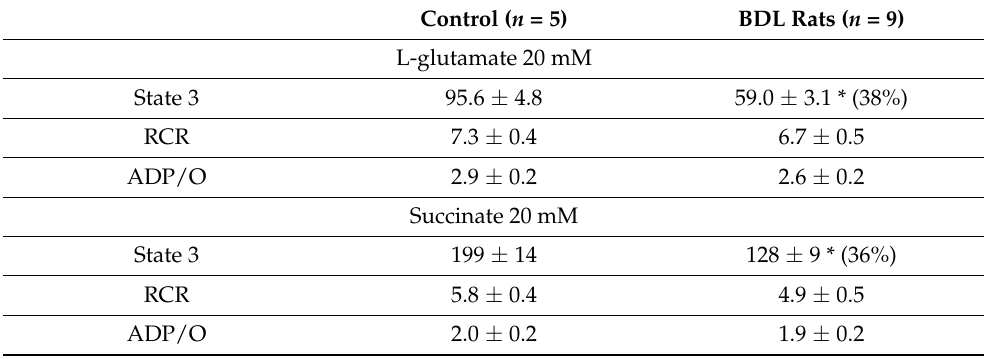
Table 4. Mitochondrial metabolism of glutamate and succinate. Rats were bile duct ligated for 4 weeks (BDL rats) or sham-operated control rats and were studied in the fed state. Mitochondria were iso- lated by differential centrifugation, as described in Methods. State 3 oxidation rates are expressed as natoms/min/mg mitochondrial protein. RCRs (respiratory control ratios) and ADP/O ratios were calculated as described in Methods. The percentage difference in the activity between BDL and control rats is given in parentheses. Data are presented as the mean ± SEM. * p < 0.05 vs. control